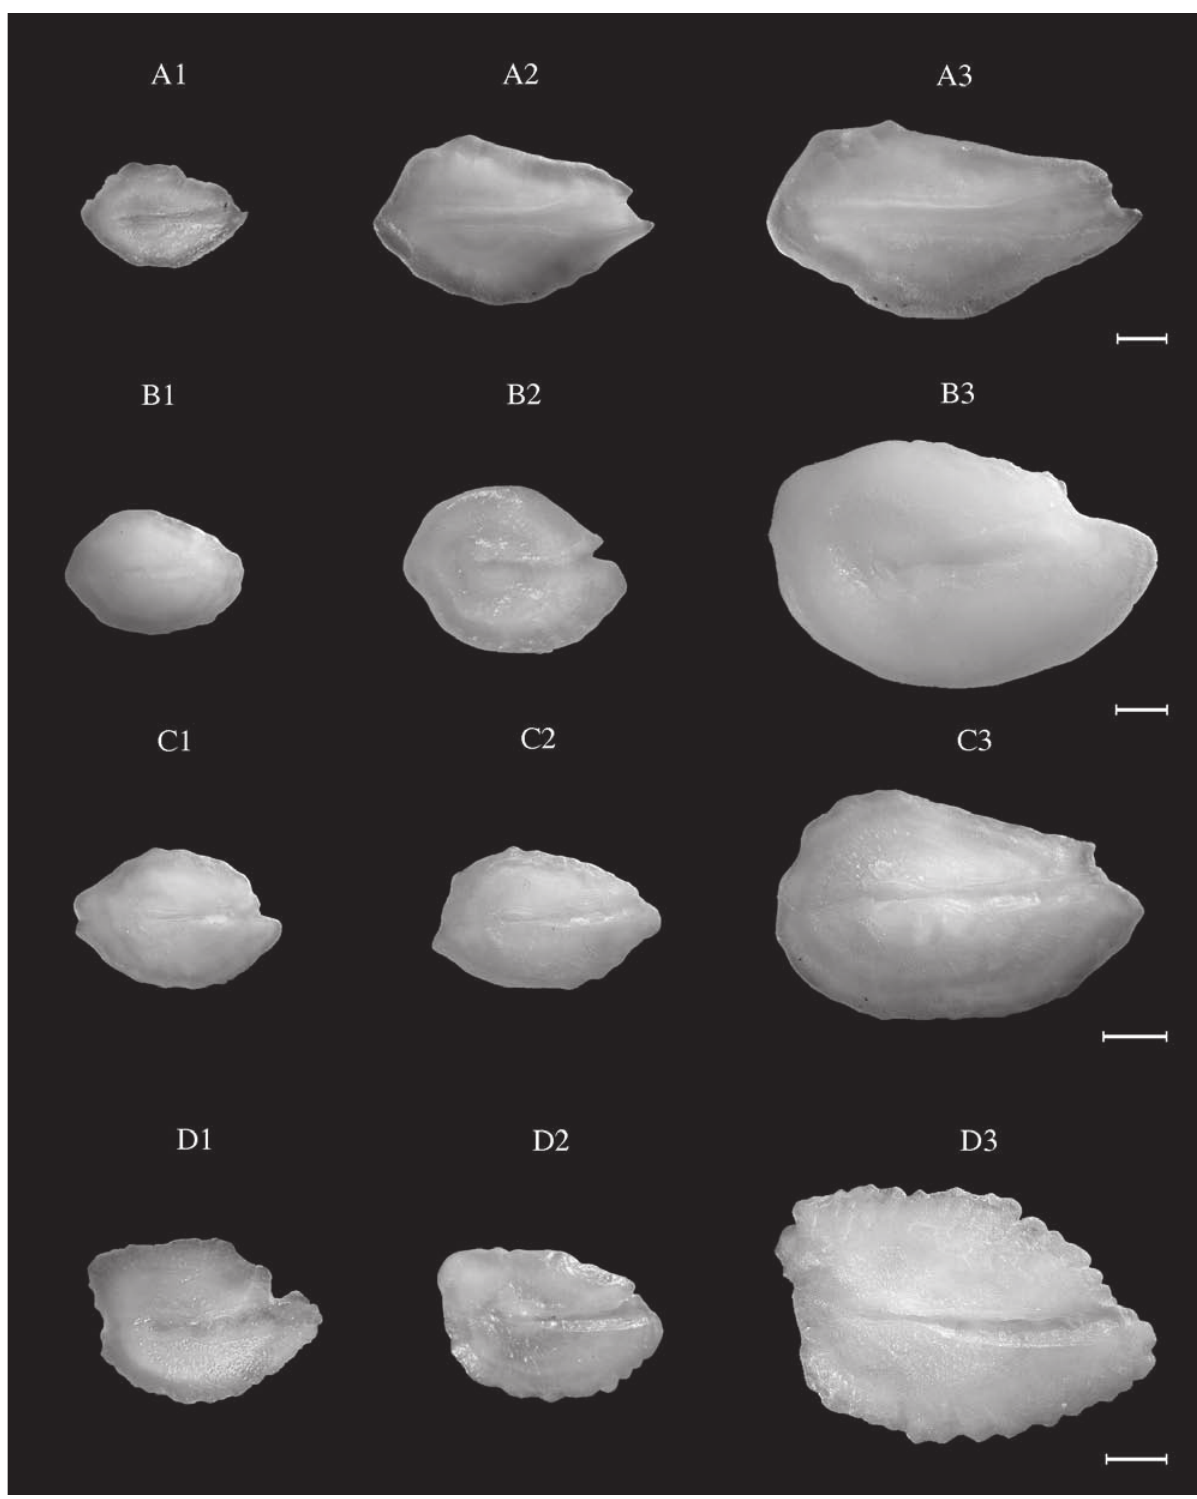
Fig. 88. – Citharus linguatula . TL: A1, 11.5 cm (WM); A2, 19.5 cm (NEA); A3, 24.6 cm (NEA). Lepidorhombus boscii . TL: B1, 15.0 cm (NEA); B2, 17.0 cm (WM); B3, 29.2 cm (NEA). Lepidorhombus whiffiagonis (NEA) . TL: C1, 15.8 cm; C2, 18.9 cm; C3, 37.9 cm. Psetta maxima. TL: D1, 19.0 cm (WM); D2, 19.2 cm (NEA); D3, 32.6 cm (NEA). Scale bar = 1